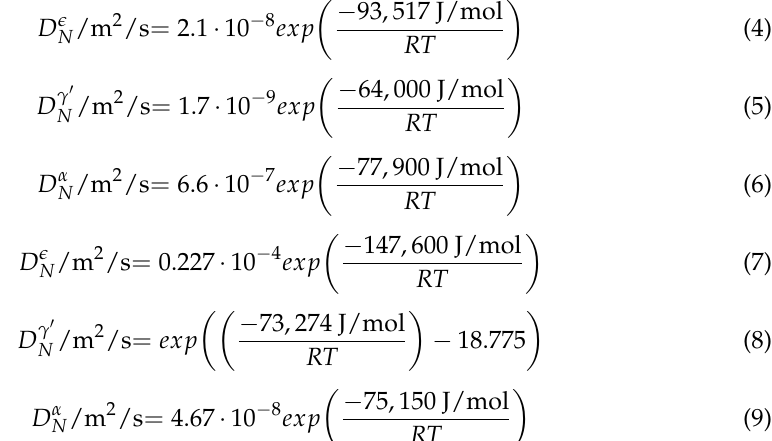
Table 4. Overview of the specific phases for the FE model and the corresponding diffusion coefficients of N in iron nitrides and the α -Fe phase with R = 8.32J/ ( mol